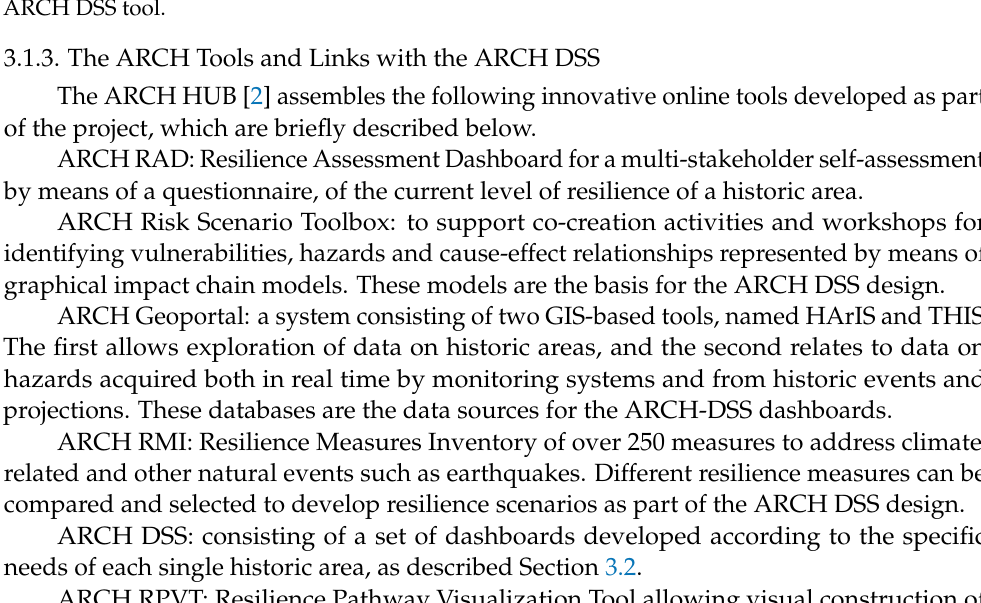
Figure 1. Illustration of the ARCH DRR/CCA framework [2] with the activities addressed by the ARCH DSS tool .